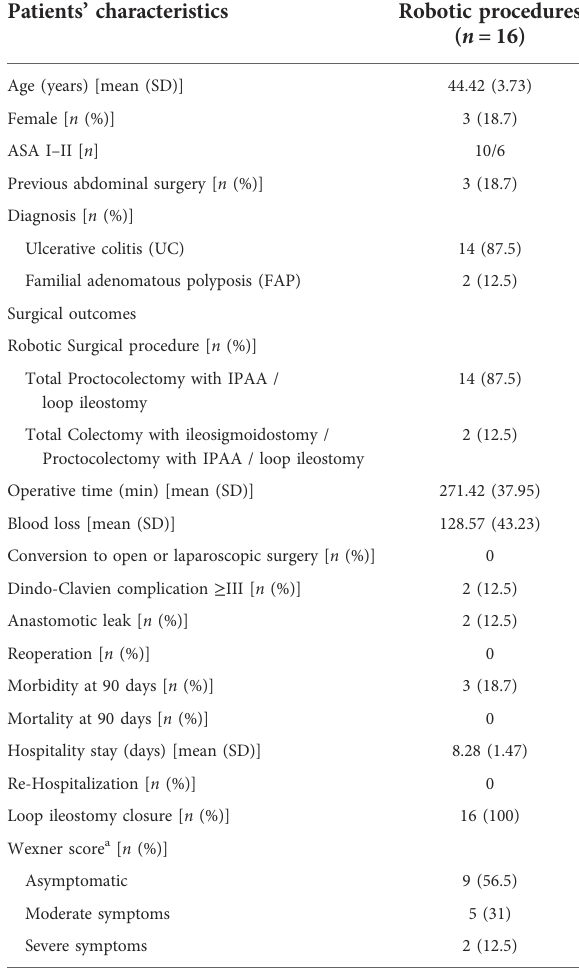
TABLE 1 Patients ’ characteristics and surgical outcomes. Patients ’